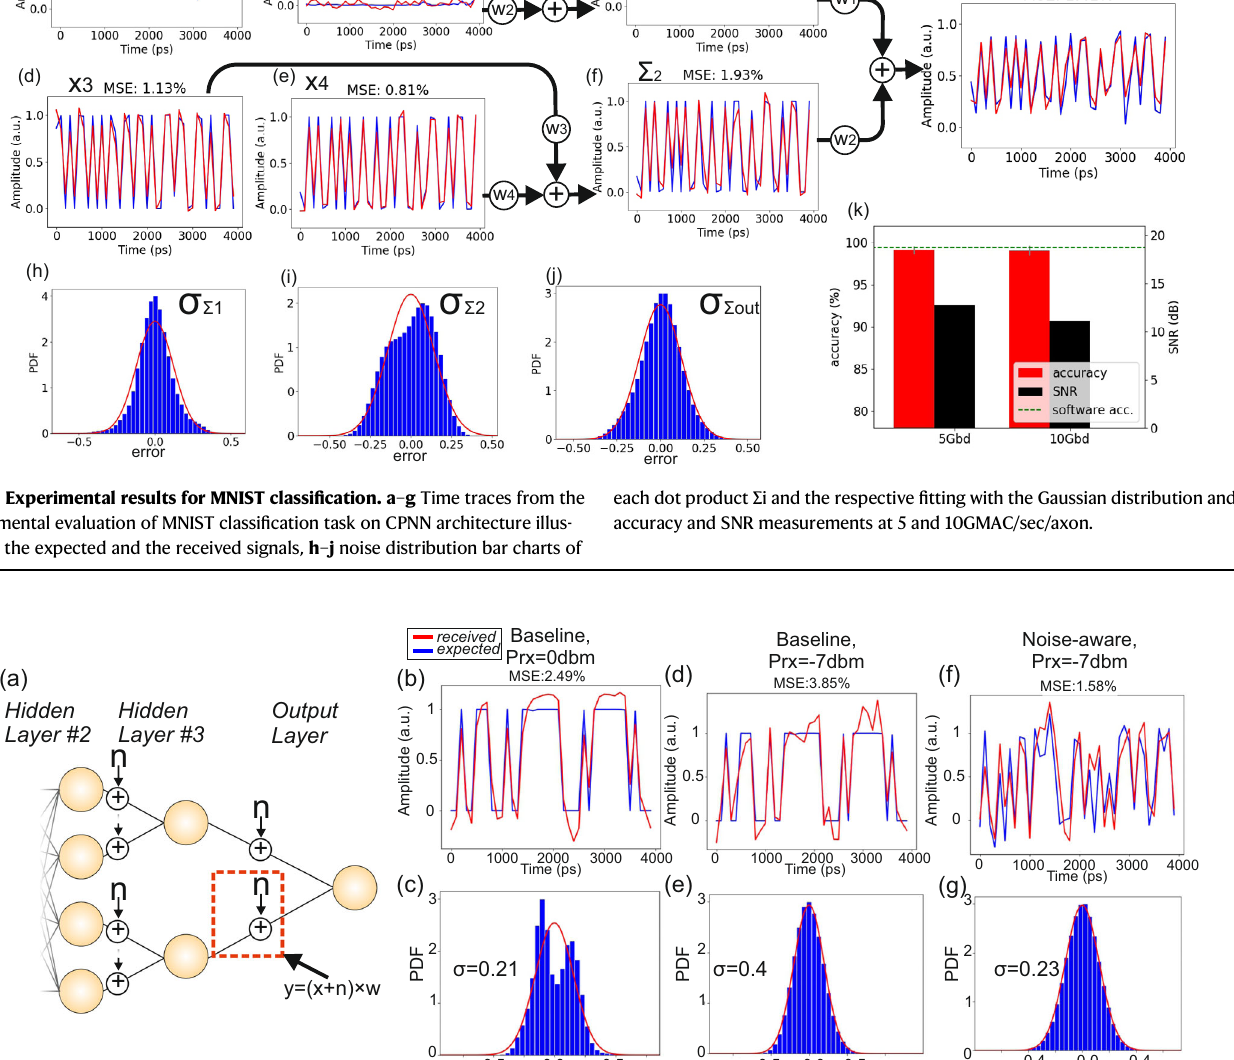
Fig. 4 | Experimental results for noise-aware training. a The modi fi ed photonic part of CPNN that incorporates AWGN sources on each x i signal, b , d , f time trace and c , e , g noisedistributionwiththerespectiveGaussian fi ttingfor:(i)thebaseline